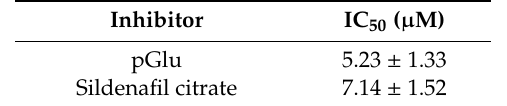
Table 1. Anti-enzymatic activities of pyroglutamic acid and sildenafil citrate against the human catalytic domain of